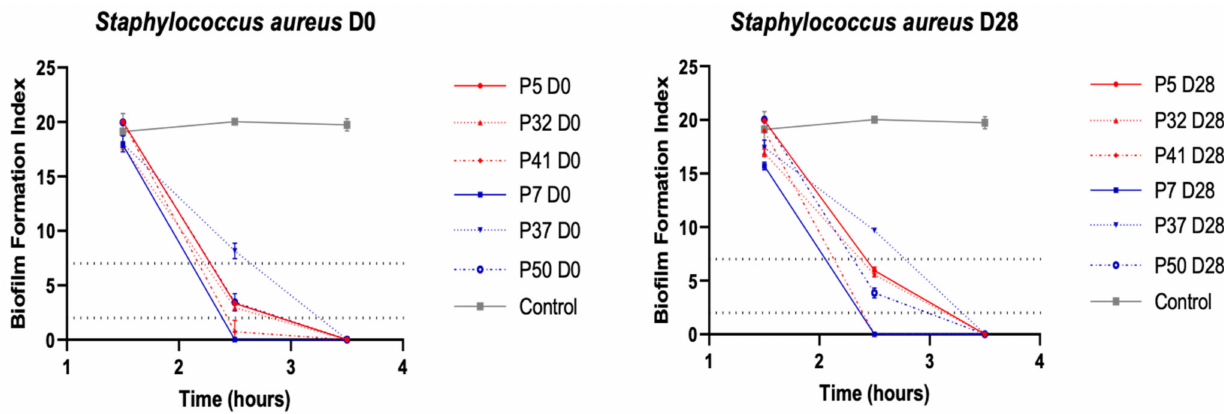
Figure 2. Biofilm formation of pairs of S. aureus isolated from pressure ulcers at D0 and D28. The kinetics of early phase of biofilm formation were determined on P5, P7, P32, P37, P41 and P50 by the BioFilm Ring Test ® (BioFilm Control, France). On right, study of S. aureus isolated at inclusion; on left, study of S. aureus isolated at day 28. In blue, S. aureus strains belonging to worsening wounds, in red, S. aureus belonging to improving wounds. Dotted horizontal lines: >7, no biofilm; <2, fixed biofilm, 2 < BFI < 7, biofilm in formation. Means ± standard errors of the mean of BFIs for at least three independent replicates are